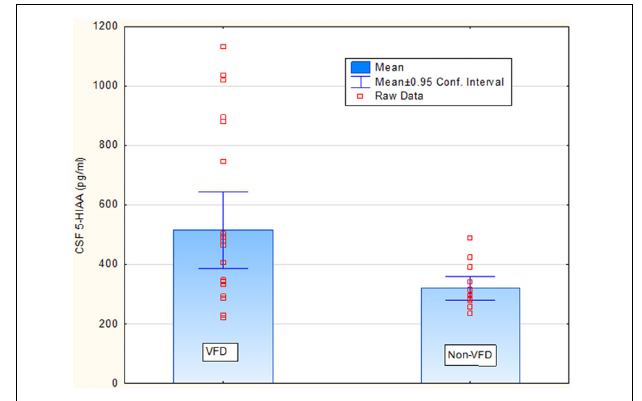
FIGURE 1 | Rearing group differences for cisternal CSF 5-HIAA concentrations in non-human primates. Covarying for age, [ F (1 , 33) = 0 . 00; p = 0 . 93], VFD-reared subjects exhibited elevated CSF 5-HIAA concentrations (ng/ml) relative to non-VFD-reared counterparts [VFD mean ( SE ) = 515.40 (50.50) ( N = 22) vs. non-VFD mean ( SE ) = 319.60 (63.30), N = 14; F (1 , 33) = 4 . 56; p = 0 . 04] whereas no group effects were observed for CSF MHPG and CSF HVA concentrations ( p > 0 . 1). The CSF 5-HIAA finding was confirmed using the non-parametric Mann Whitney U ( Z = 2 . 28; p = 0 .